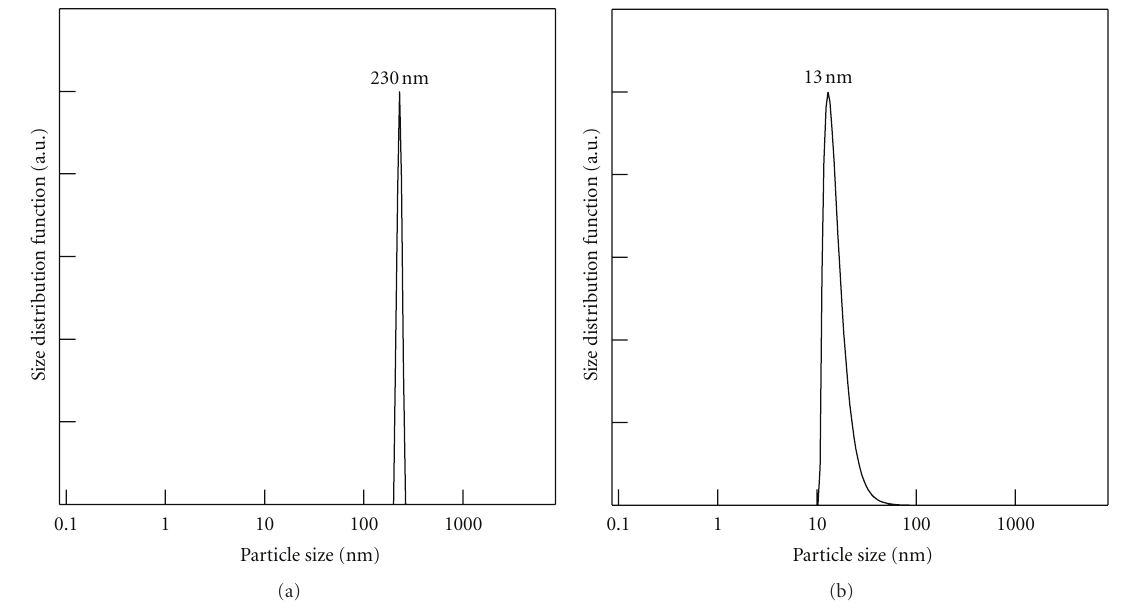
Figure 2: DLS measurements of TiO 2 -MG (a) and TiO 2 -BM (b)